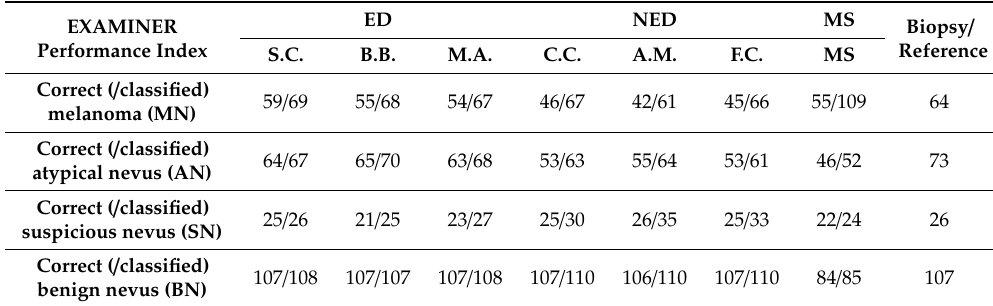
Table 5. Comparison of lesion classification results by expert (ED) / non-expert (NED) dermatologist groups and automatic measurement system